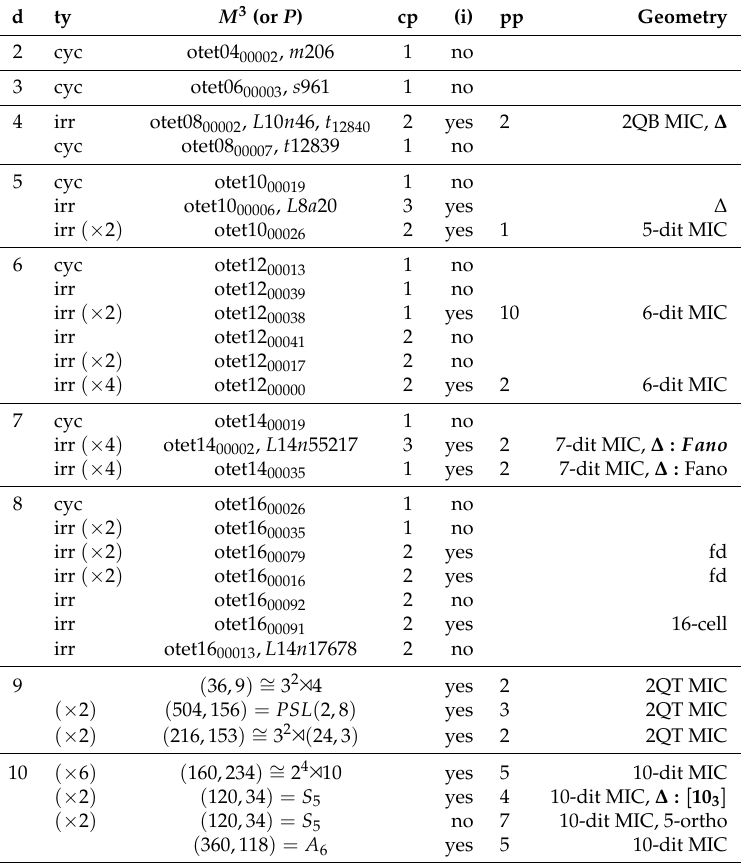
Table 2. Table of 3-manifolds M 3 found from subgroups of finite index d of the fundamental group π 1 ( S 3 K 4 a 1) (alias the d -fold cov- \ erings over the figure-eight knot 3-manifold). The covering type ‘ty’